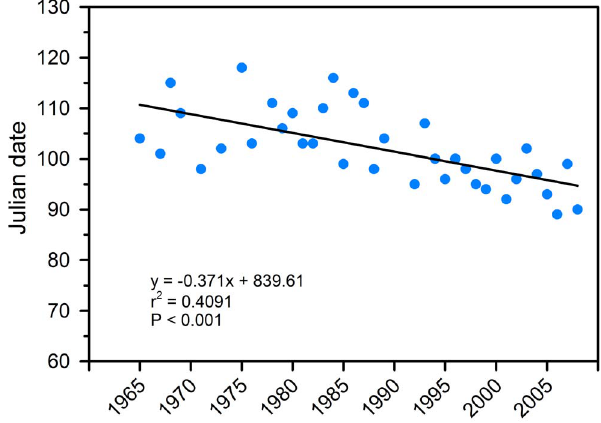
Figure 2. The date that American white pelicans first arrived each year at a breeding colony in Chase Lake National Wildlife Refuge in Stutsman County, North Dakota, during a 44-year period (1965–2008). Pelicans showed a trend toward earlier arrival, with arrival dates advancing approximately 16 days in the 44-year period. Arrival dates were not recorded for 1966, 1970, 1972, 1974, 1977, 1990, and 1991.